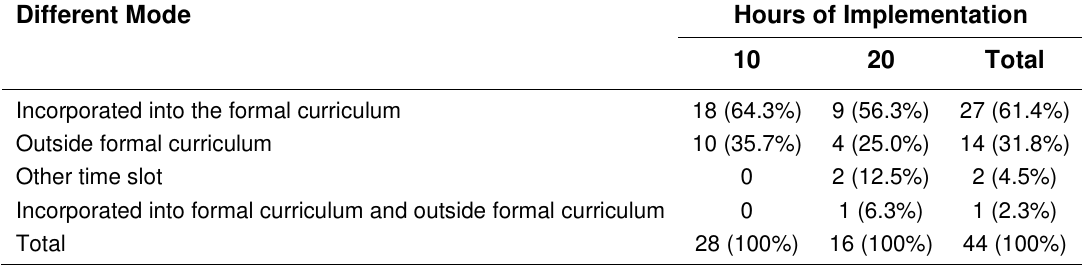
The Distribution of Observed Tier 1 Program Units Implemented in Different Modes for Schools Adopting 10 and 20 Hours of